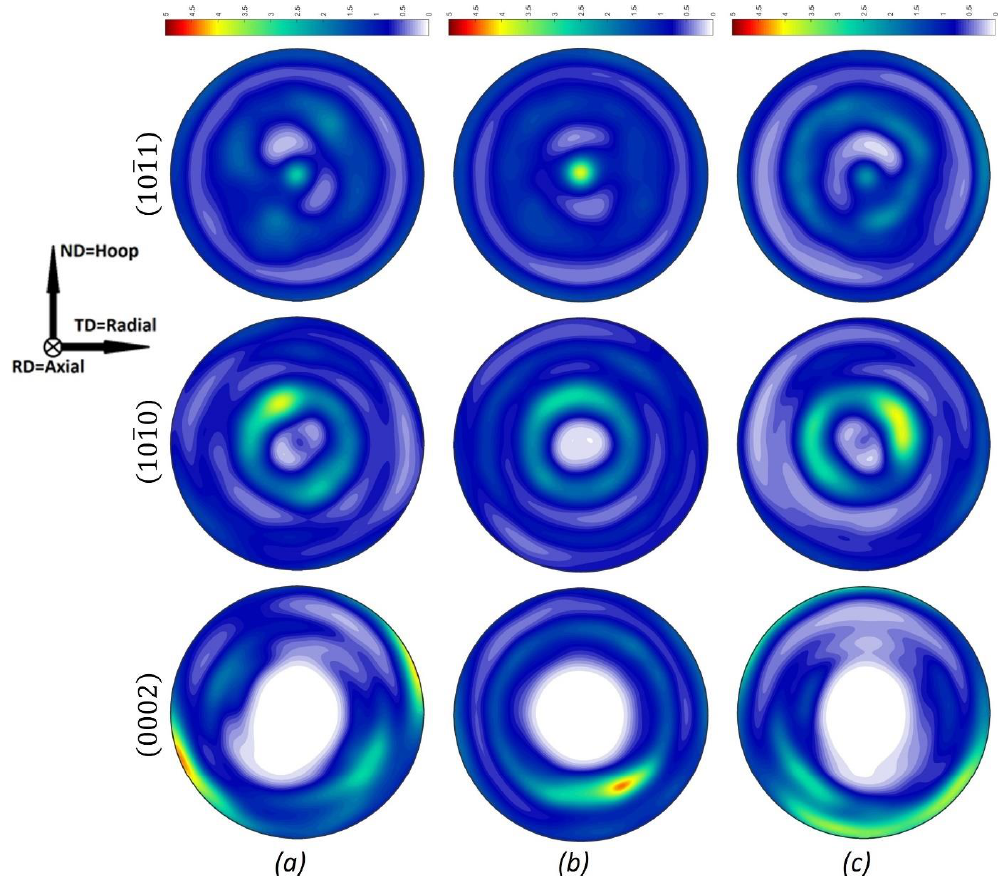
(cid:0) (cid:1) (cid:0) (cid:1) Figure 9. ( 0002 ) , 1010 , and 1011 pole figures after the second C-ECAP pass in the periphery ( a , c ) Figure 9. (0002) , (101̅0) , and (101̅1) pole figures after the second C-ECAP pass in the periphery and in the central region ( b ) of the ( a , c ) and in the central region ( b ) of the sample.